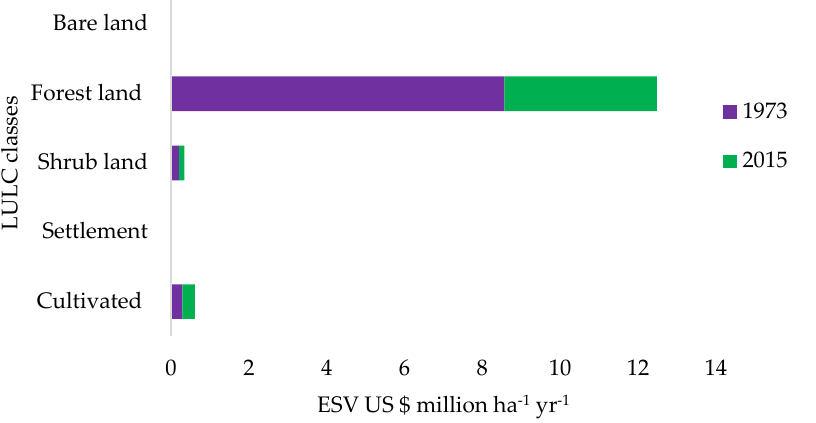
Figure 11. ESVs from 1973 to 2015 in Chillimo forest, Ethiopia (Source of data: Tolessa et al. [5], but figure done by authors).